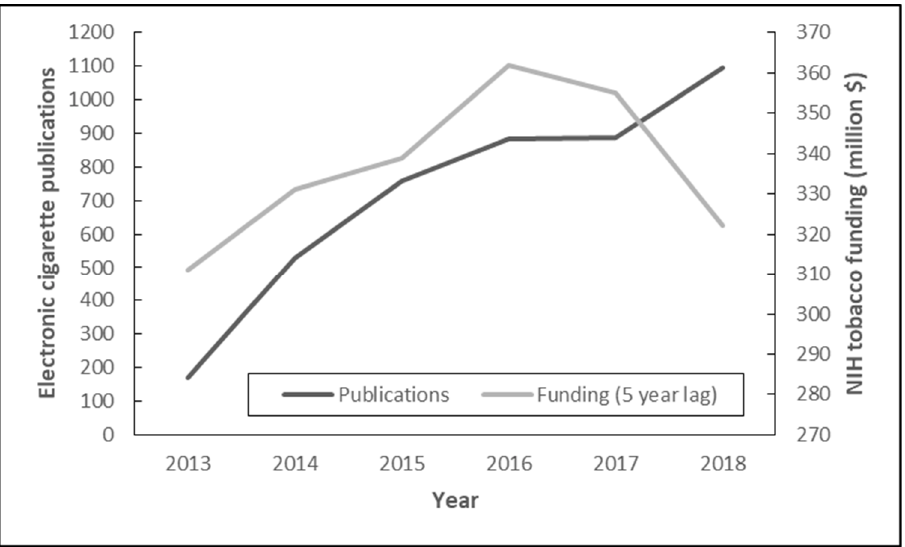
Figure 2. National Institutes of Health (NIH) tobacco funding with a 5-year lag time and electronic cigarette publications from 2013 to 2018.